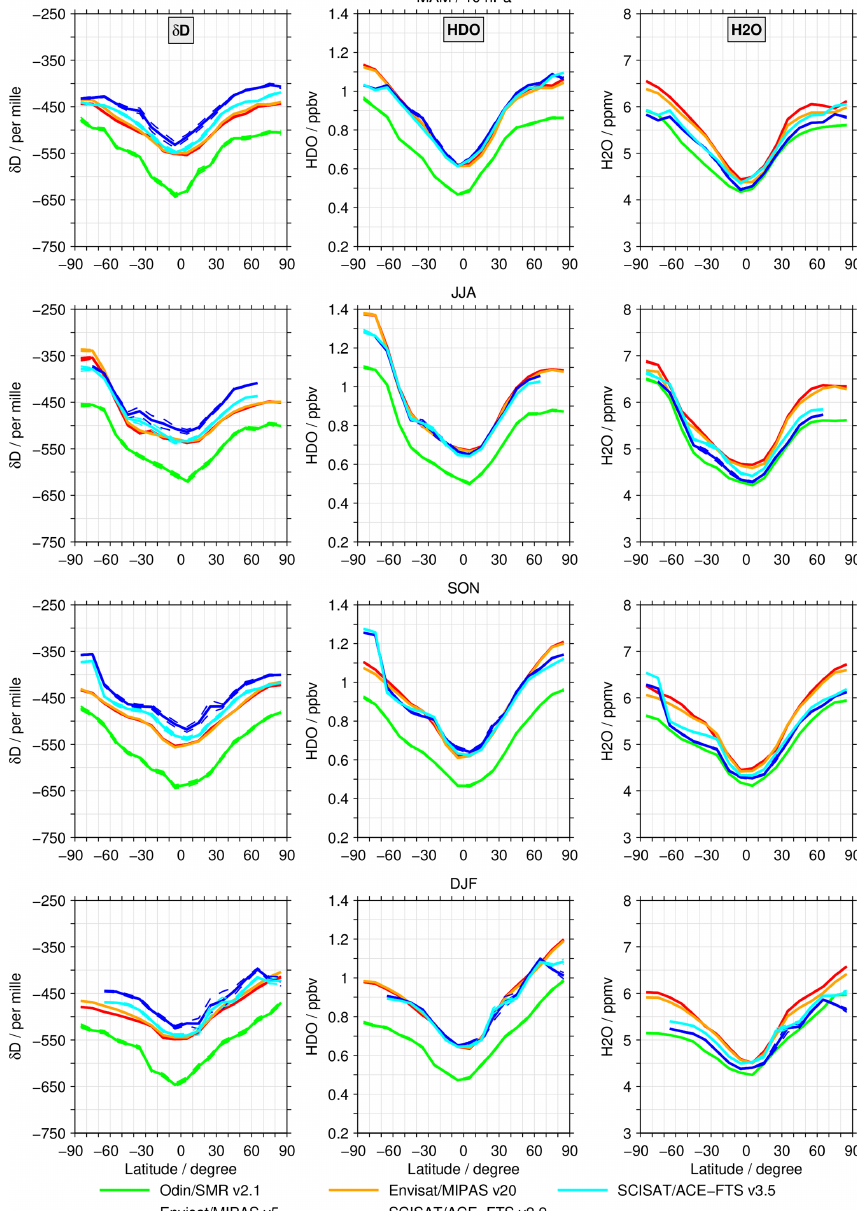
Figure 5. As for Fig. 4 but considering the 10hPa level.